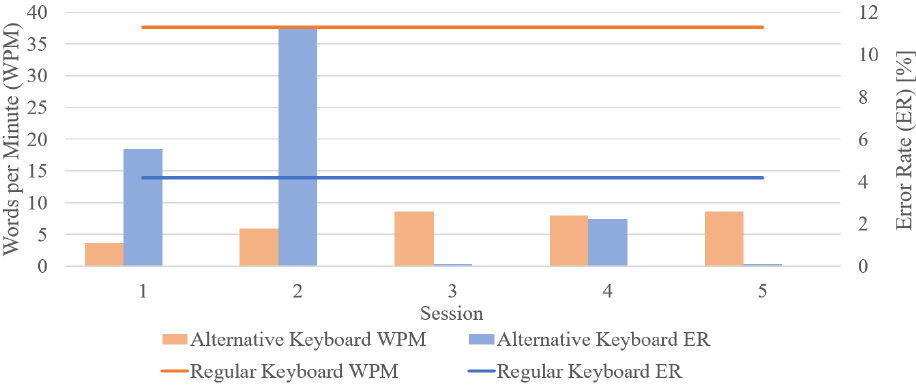
Figure 14. WPM and ER plotted for sessions using the alternative and regular